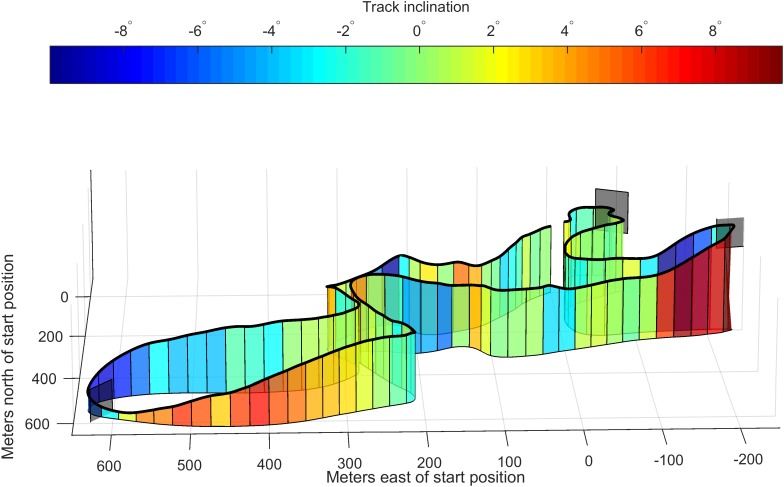
Track topography (vertical coordinates are multiplied by a factor of 3). The gray planes indicate the four sections to avoid local minima during the mapping procedure (see the section “Mapping trajectory”).